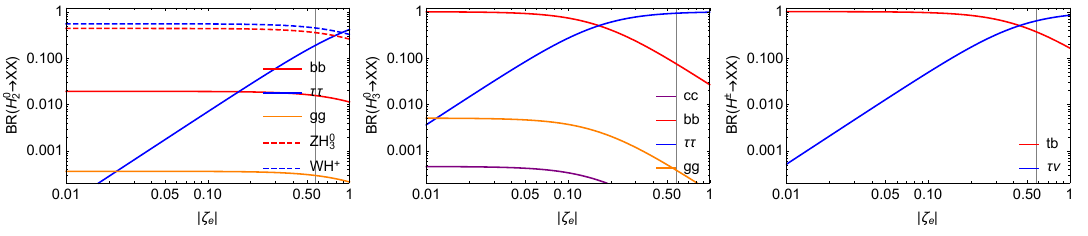
Figure 7 . Branching ratios of H 0 the (cid:12)xed parameters given in table 3. The vertical line denotes the upper limit j (cid:16) e j > 0 : 58 by the electron